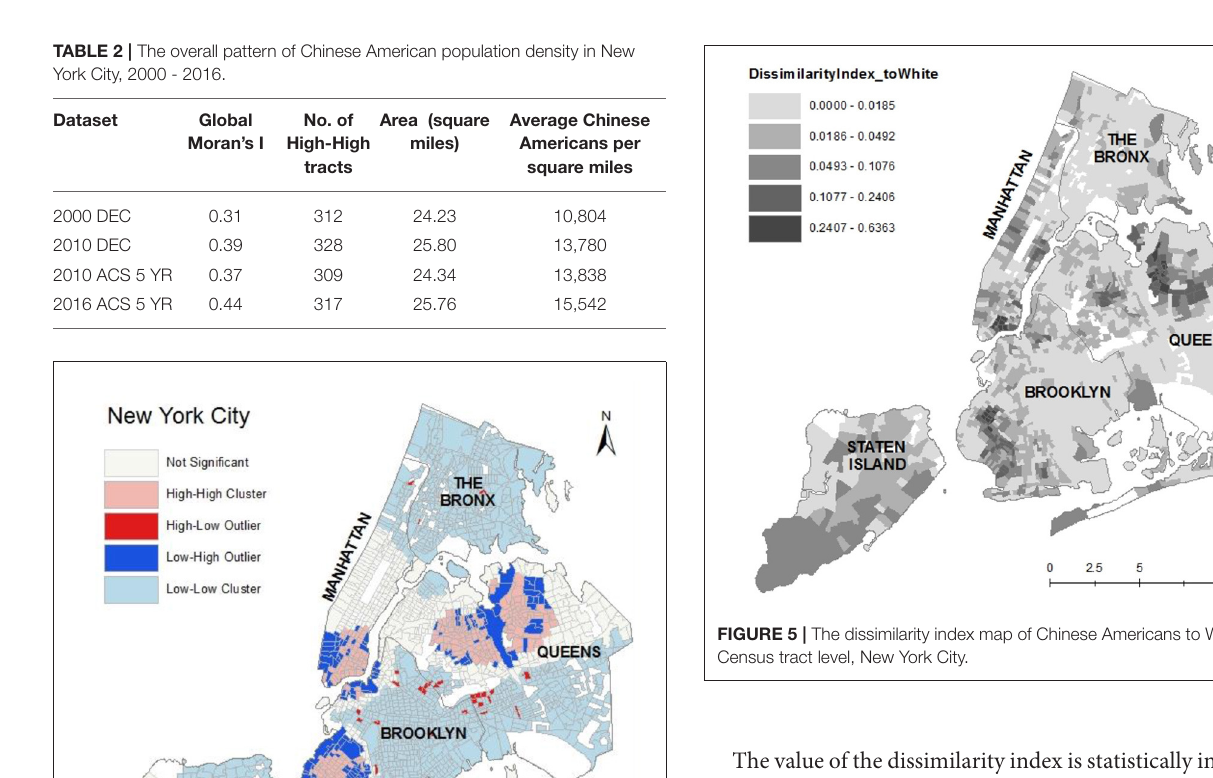
The value of the dissimilarity index is statistically independent from the relative sizes of the groups used in its